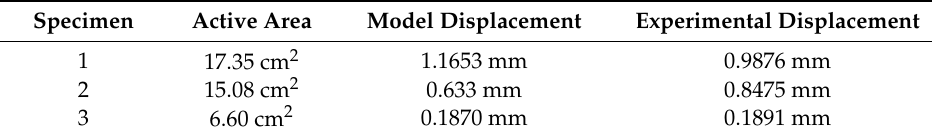
Figure 8. Model Z -Axis Displacement Results for Set 3 at 5000 V. Table 7. Comparison between Model and Experimental Results.